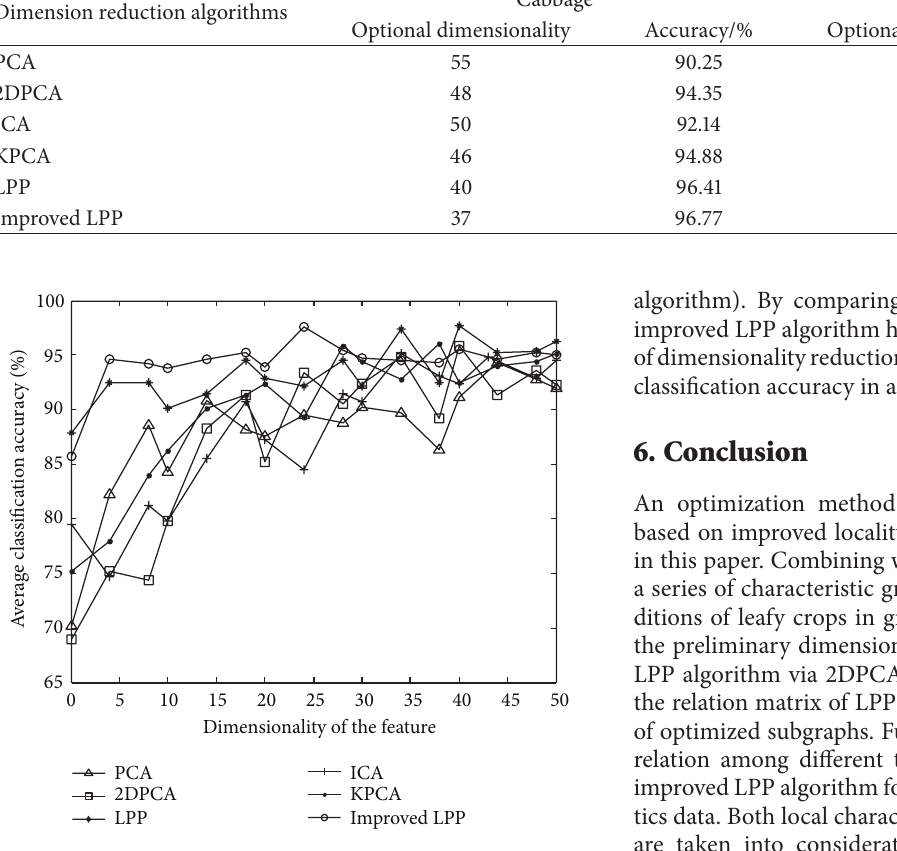
Figure 4: Classification result of data from lettuce